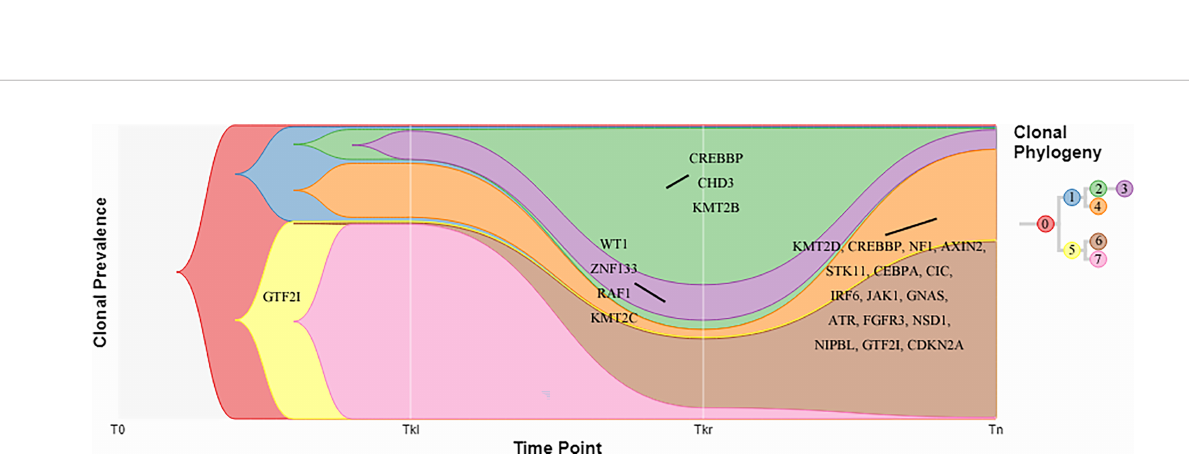
FIGURE 4 | Analysis of heterogeneity between different lesions. (A) Two-dimensional analysis of tumor subclonal architecture in right kidney (Tkr) and left kidney (Tkl); and (B) in neck (Tn) vs . left kidney (Tkl); and (C) in neck (Tn) vs . right kidney (Tkr). These subclones were shared between the spatially distinct lesions.